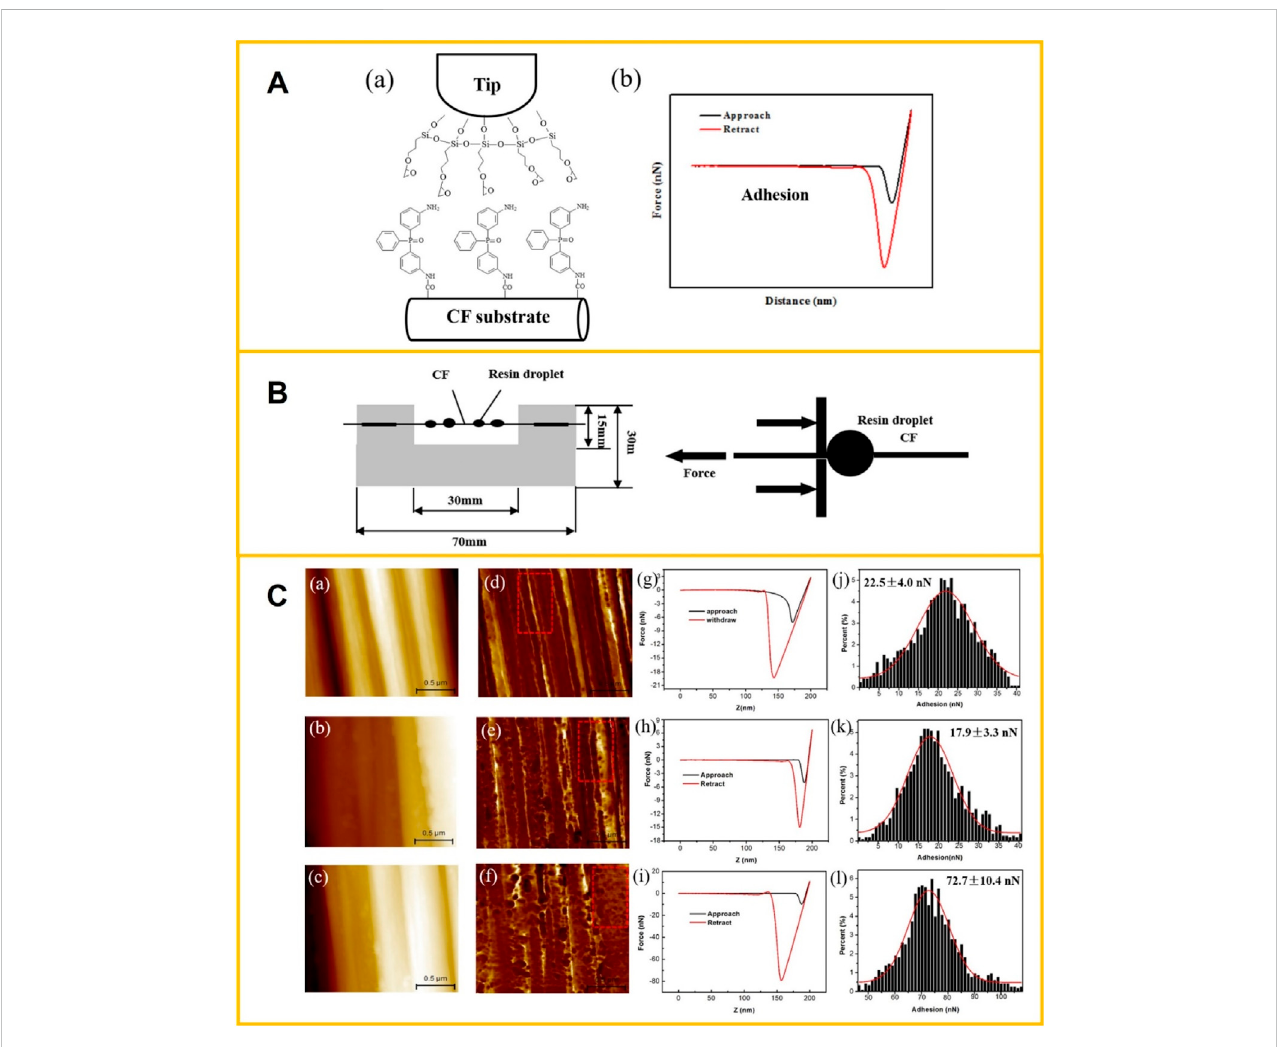
FIGURE 9 (A) Schematic diagram for the adhesion force measurement: (a) Epoxy functionalized tip and Bis (3-aminophenyl) phenyl phosphine oxide (BAPPO) modi fi ed CF; (b) typical force-distance curves during the adhesion force measurement. Reprinted with permission from (Zheng et al., 2018). Copyright 2018ElsevierLtd. (B) Schematicillustrationofsingle fi bermicrobondtest.Reprintedwithpermissionfrom(Zhengetal.,2018).Copyright2018ElsevierLtd. (C) Adhesion force measurement between the epoxy functionalized tip and CF samples. (a – c) AFM images of the as-received CF, de-sized CF and BAPPO- CF used in adhesion force measurement, respectively. (d – f) The corresponding adhesion maps of (a – c). (g – i) the representative force-displacement curves during the adhesion force measurement process. (j – l) Histograms of the measured adhesion forces between the epoxy functionalized tip and CFs. Reprinted with permission from (Zheng et al., 2018). Copyright 2018 Elsevier